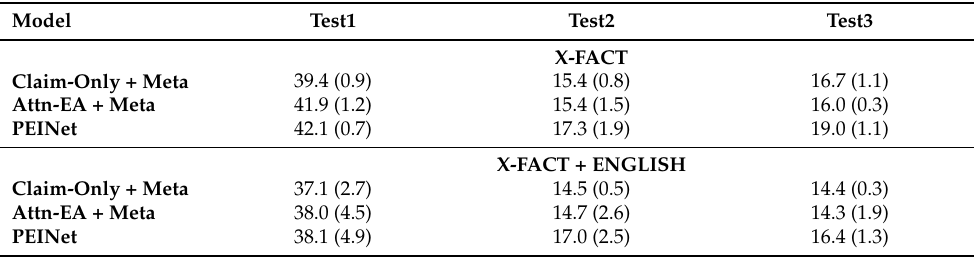
Table 8. Performance comparison analysis of different models with the augmenting data and origi- nal